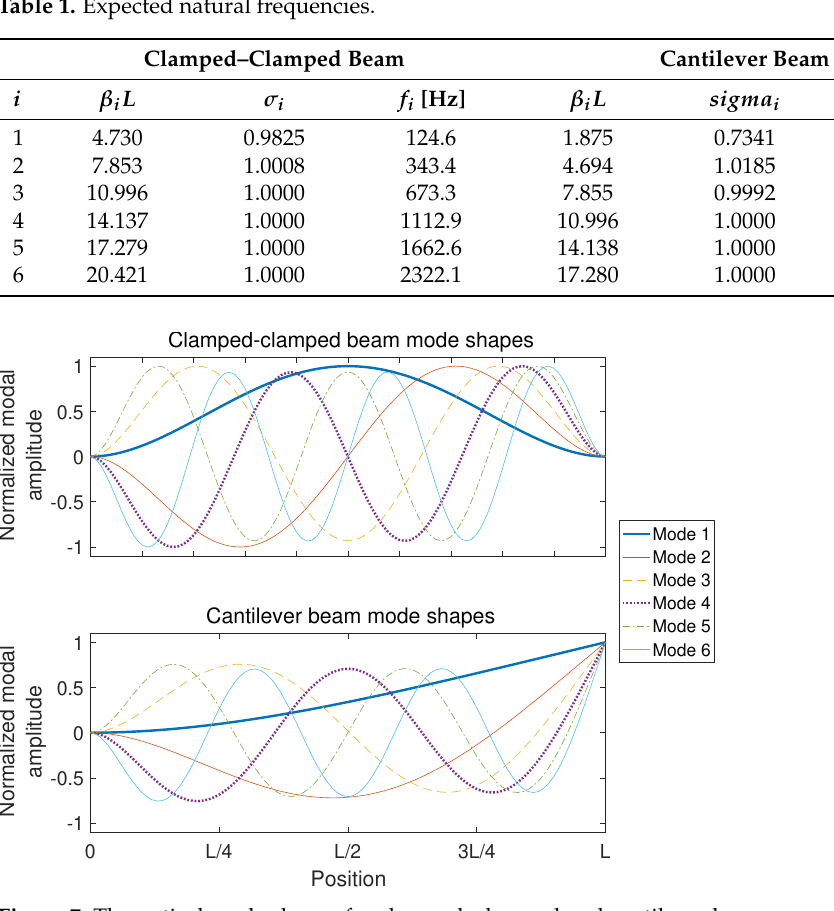
Figure 7. Theoretical mode shapes for clamped–clamped and cantilever